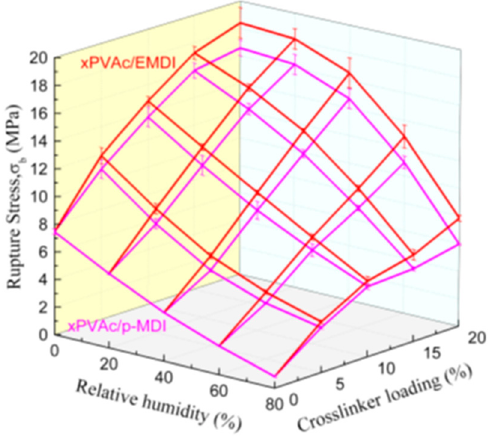
Figure 2. Effect of EMDI (red line) and p -MDI (magenta line) on the rupture stress of EPI film at different relative humidity.